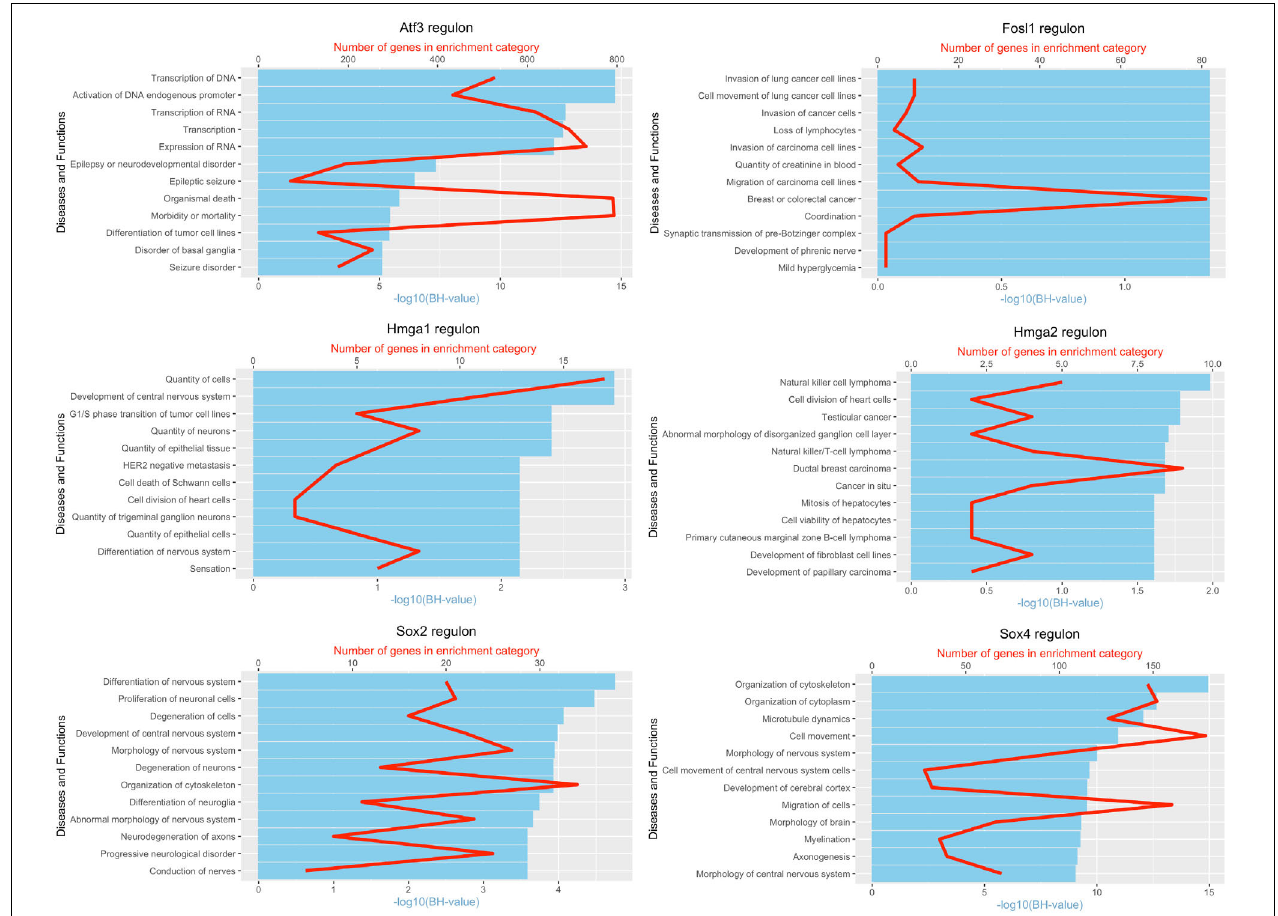
FIGURE 11 | Pathway and functional enrichment analysis of Atf3, Fosl1, Hmga1, Hmga2, Sox2, and Sox4 in Schwann cells at day 9